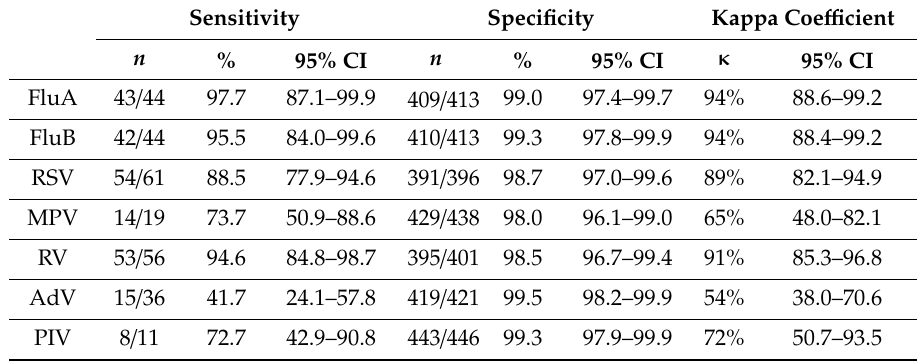
Table3. ClinicalsensitivityandspecificityofPantherFusionrespiratorypanelsfortheprospectivephase.